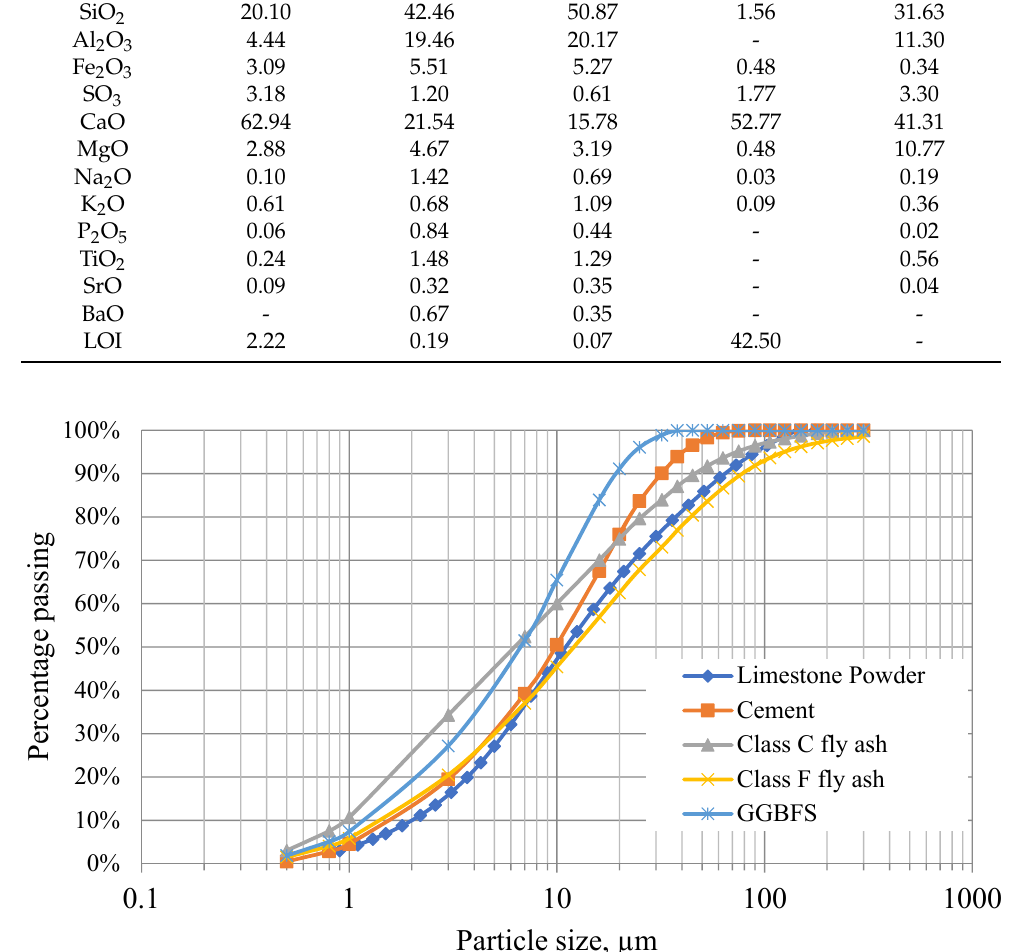
Figure 1. Particle size distribution of cement, SCMs, and filler (25 mm = 1 in.). Table 2. Physical properties of aggregates (25 mm = 1 in.).